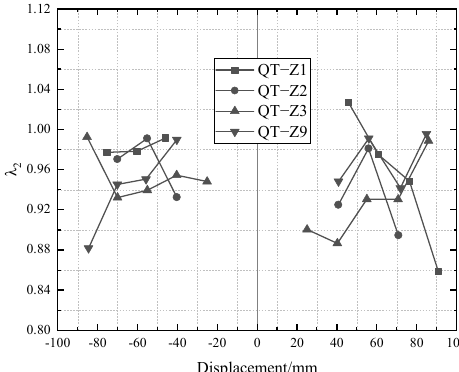
Figure 20. Degradation coefficient λ 2.